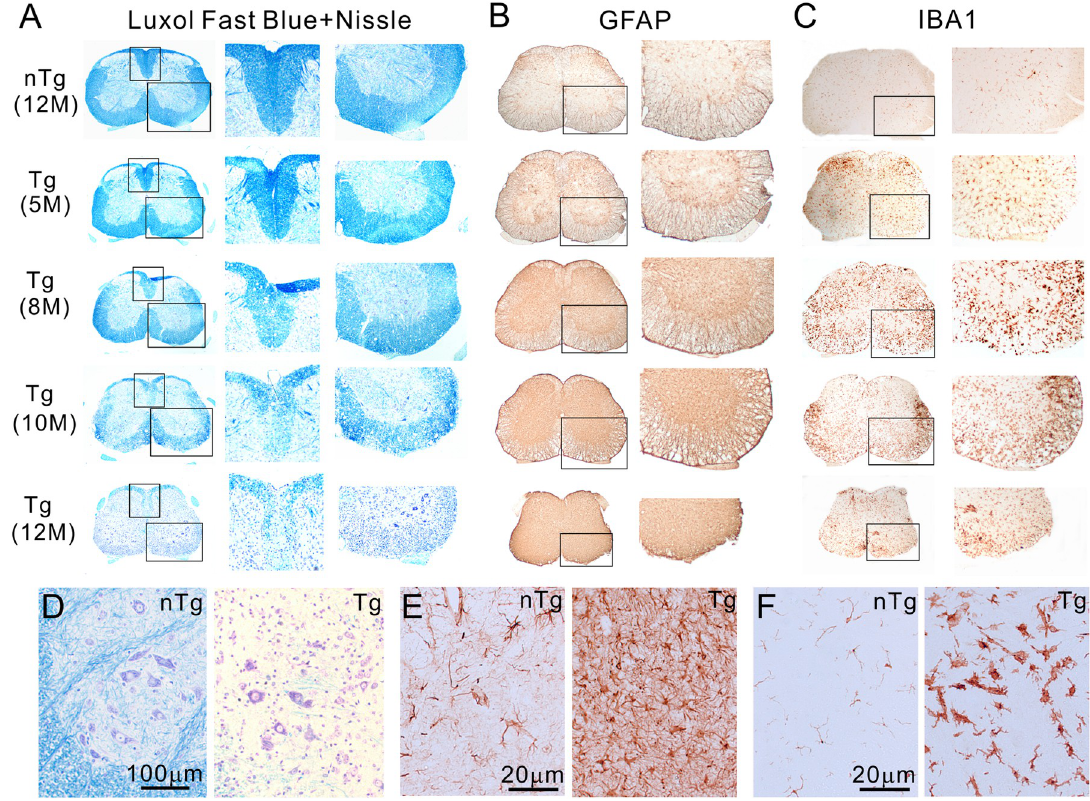
Fig 5. The Tg mice developed age-dependent myelin degeneration and gliosis in the spinal cord. (A) Late-onset, progressive demyelination, (B) astrogliosis and (C) microgliosis in the lumbar spinal cord of the Tg mice. The right panels are magnified views of boxed areas in the left panels. (D, E, F) Enlarged views of ventral horn stained with Luxol Fast Blue and Cresyl violet, GFAP and Iba1, respectively. Shown are images representative of five or more animals for each genotype and at each time